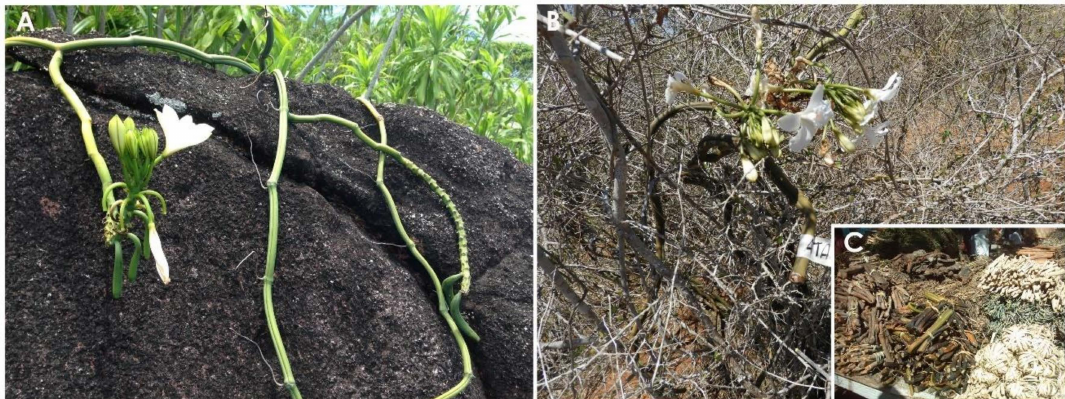
Figure 3. Ecology and usages of leafless Vanilla species: ( A ) V. phalaenopsis individual growing on a rock in Seychelles, ( B ) V. decaryana plant in thorny bushes in the south of Madagascar (Antandroka) and ( C ) leafless Vanilla stems for sale on the Tul é ar market (Madagascar). (Photographies A, C: Pascale Besse, B: Cathucia F.